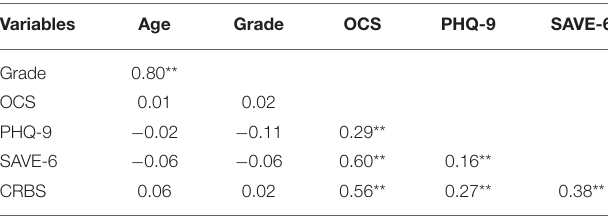
TABLE 2 | Spearman’s correlation coefficients (rho) of each variables for all